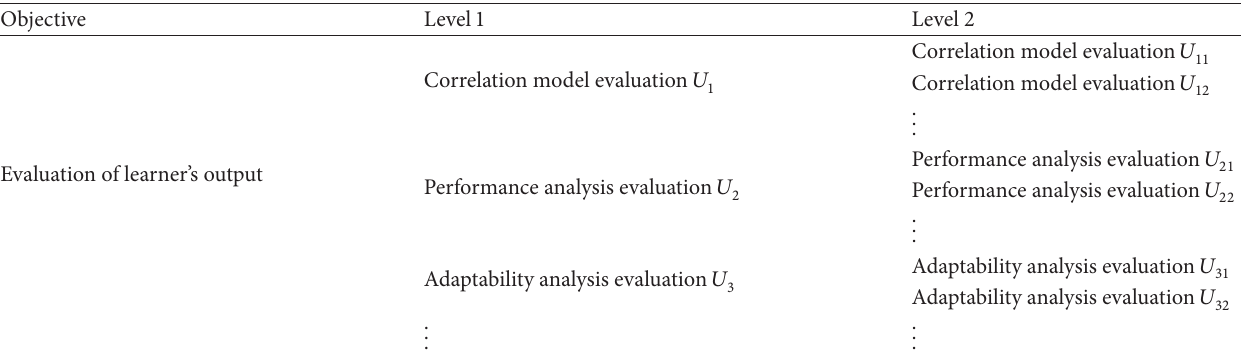
Table 1: Evaluation factor hierarchical